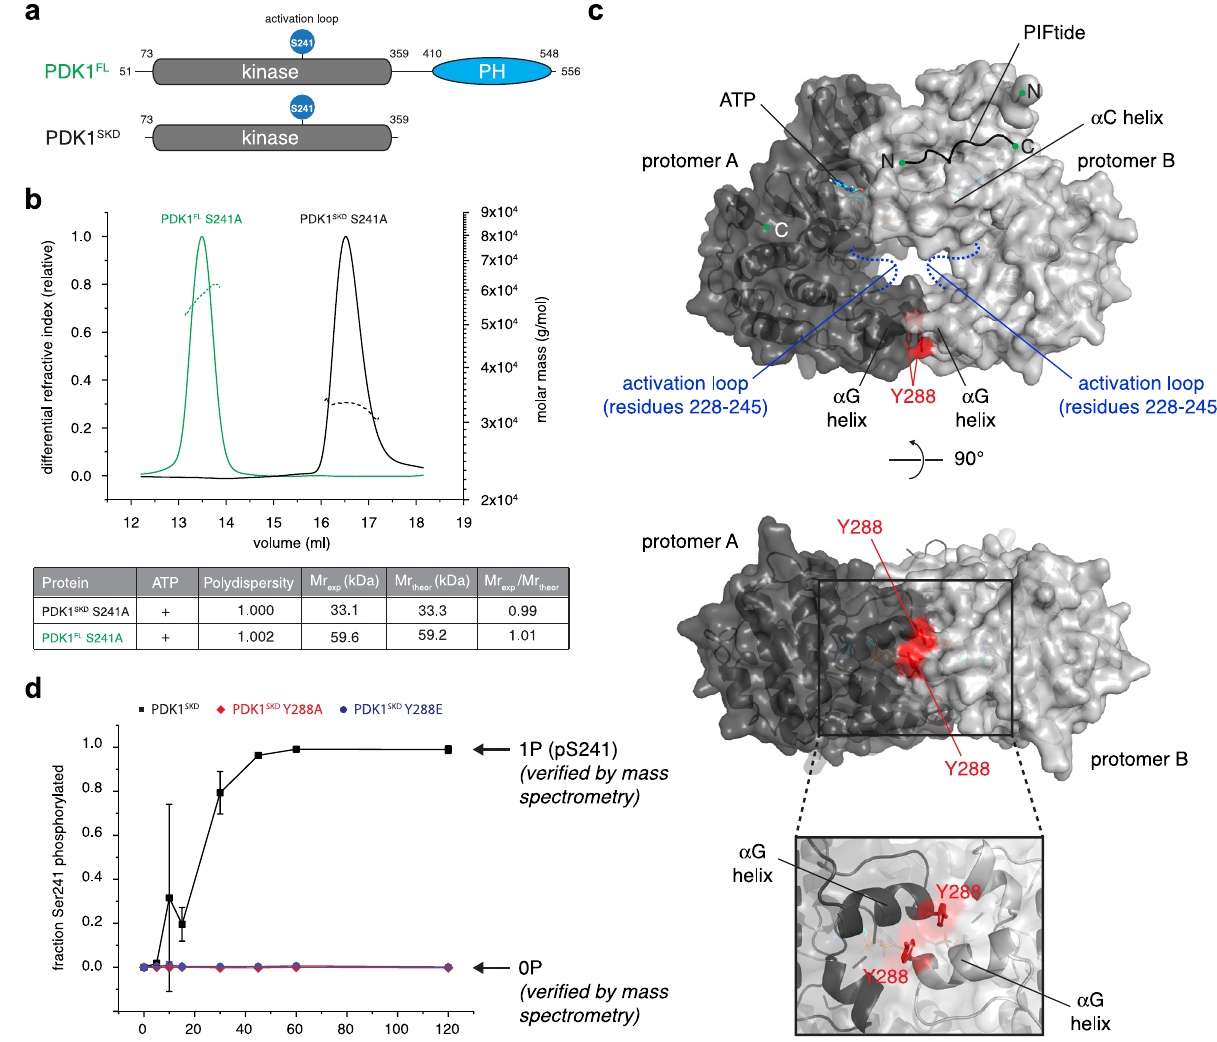
PDK1 FL (full length) and PDK1 SKD (short kinase domain). b Size exclusion chromatography coupled to multi-angle light scattering (SEC-MALS) of PDK1 FL S241A (green) and PDK1 SKD S241A (black). The table summarizes protein polydispersity, theoretical (Mr theor ) and experimentally determined (Mr exp ) molecular weights, as well as the calculated oligomeric state (Mr exp /Mr theor ). c Model of the PDK1 kinase domain dimer obtained using the ROSETTA symmetric modeling tool. Kinase domains (PDB: 2biy) are shown in dark and light gray. Activation loop residues 228 – 245 that were removed from the structure for the purpose of modeling are shown in dashed blue lines. The hydrophobic motif of PRK2 (PIFtide) bound to the hydrophobic pocket (PDB: 4rrv) is depicted with a black line. Y288 in the dimer interface is highlighted in red. d Radiometric PDK1 autophosphorylation assay. PDK1 SKD (closed black squares), PDK1 SKD Y288A (closed red diamonds), and PDK1 SKD Y288E (closed blue circles). n = 3 biologically independent experiments. Data